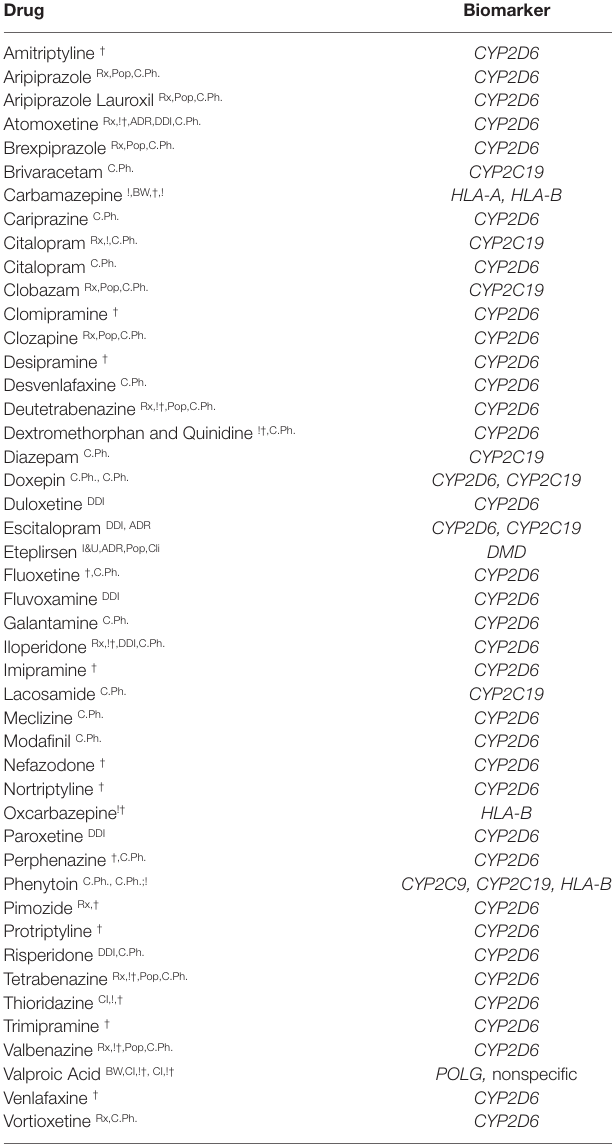
TABLE 2 | The 45 drug products that are FDA-approved for use in neurology and psychiatry that contain pharmacogenomic information in their drug labels, and the gene/biomarker of interest for each. A total of 36 drug labels include actionable or informative pharmacogenomic information in labeling sections Dosage and Administration, Warnings and Precautions, Adverse Reactions, Drug Interactions, Clinical Pharmacology, and Use in Specific Populations